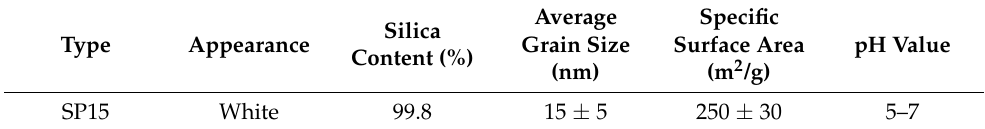
Table 3. Properties of NS powder.